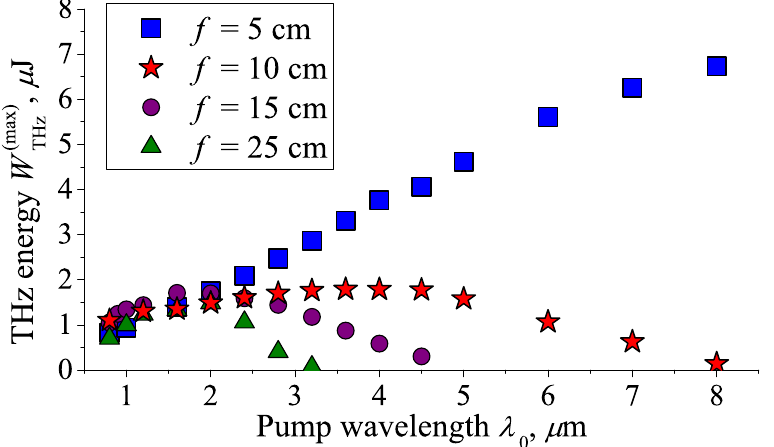
Figure 1. The maximal energy of generated THz radiation W (max) versus the pump wavelength λ 0 for four focal distances: 5 cm (blue squares), 10 cm (red stars), 15 cm (violet circles), and 25 cm (green